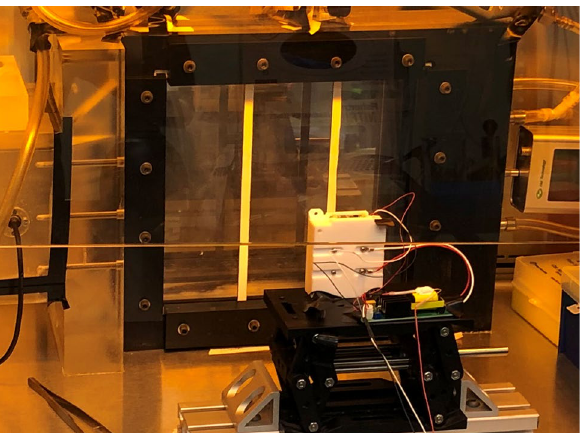
Figure 1. The experimental configuration at Columbia University had a flow-through aerosol irradiation chamber with a 222 nm filtered far-UVC lamp placed 22 cm